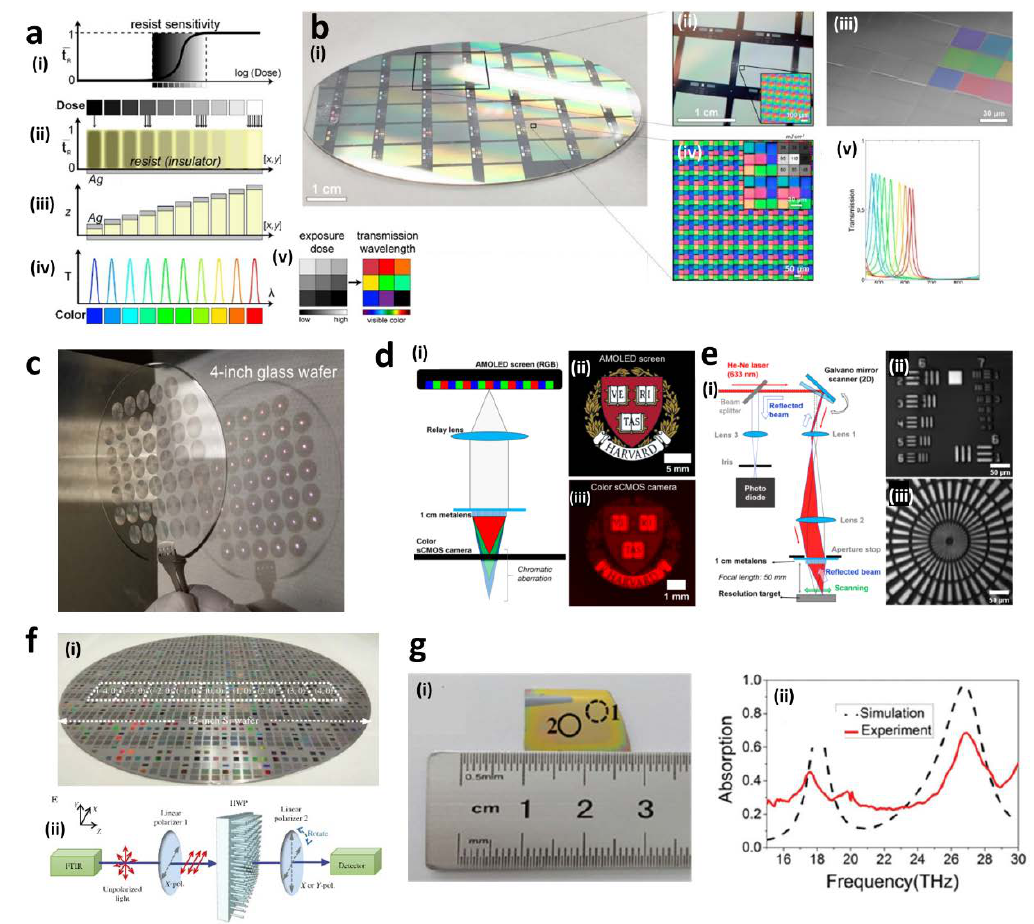
Figure 2. ( a ) Grayscale photolithography process of a multispectral filter array (MSFA) [69]. (i) Calculated profile of grayscale exposure dose, (ii) profile of a resist after exposure, (iii) the spatially variant three-dimensional (3D) resist profile after development and metal deposition, (iv) calculated transmittance spectra, and (v) spatially variant grayscale exposure dose matrix. ( b ) (i) Photographs of a 3 in MSFA, (ii) magnified (i) in a certain region, (iii) tilted SEM micrograph, (iv) optical micrograph of the di ff erent regions with each labeled identical exposure pattern (inset), and (v) the corresponding transmission spectra. ( c ) A tilted photograph of total 45 metalenses of 1 cm diameter on a 4 in a wafer [70]. ( d ) (i) Schematic of an active-matrix organic light-emitting diode (AMOLED) screen imaging, (ii) an image of Havard logo on the AMOLED screen, (iii) the measured image by a scientific